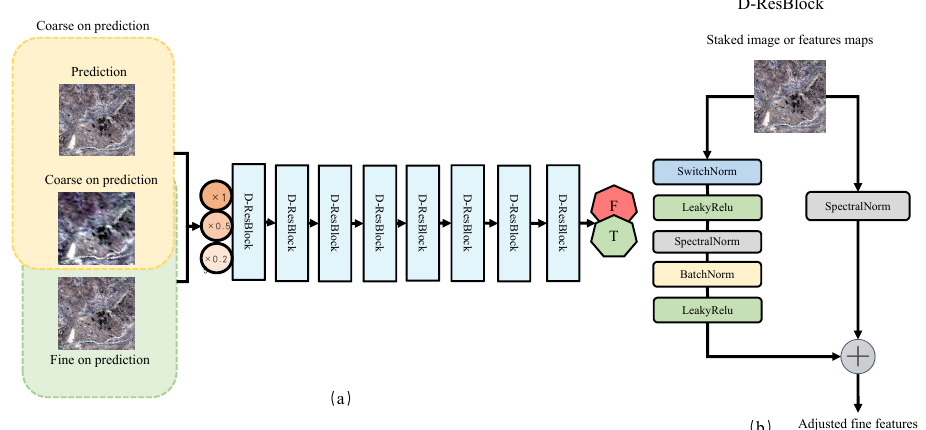
Figure 6. Structure diagram of the Discriminator model. (( a ) in the figure shows the overall structure diagram of the discriminator, in which the input of the original discriminator is sampled at three levels with factors of 1, 0.5, and 0.25 to train the multi-scale discriminator. D-ResBlock is the residual block used in the discriminator. The details of these basic building blocks are shown in Figure ( b ). The input of the original discriminator is sampled at three levels with a factor of 1, 0.5, and 0.25 to train the multi-scale discriminator).